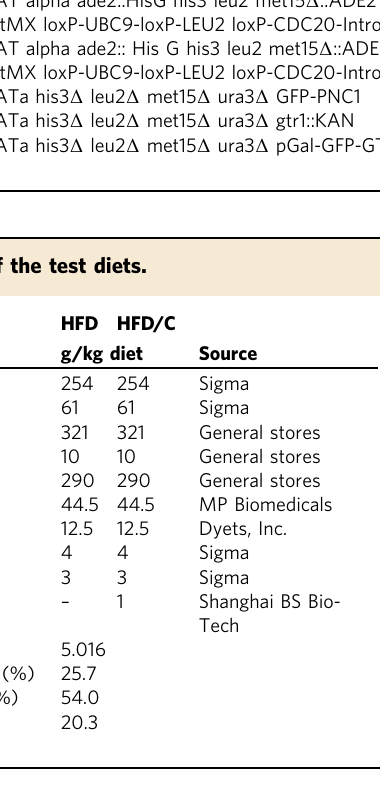
Table 2 Genotypes of yeast strains.